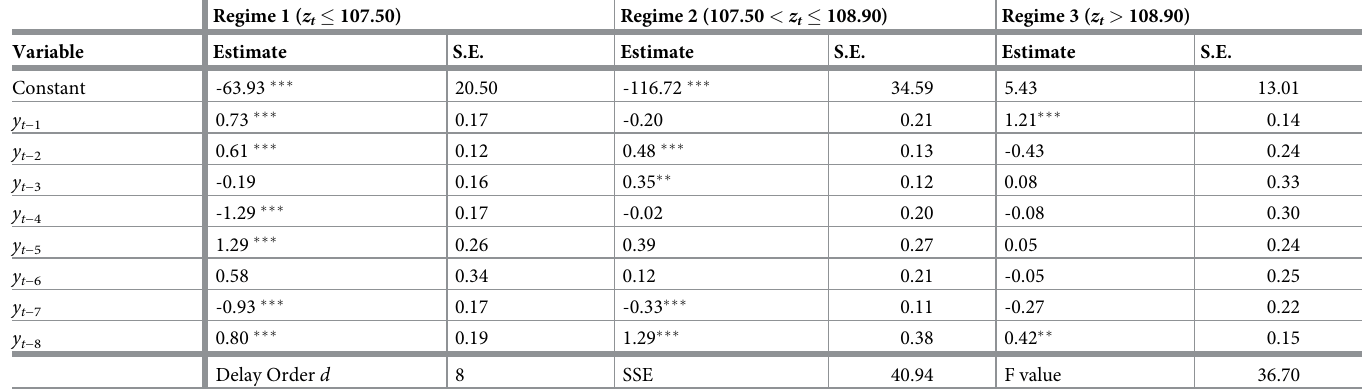
Table 6. The results of the threshold auto-regression model of the GDP growth rate. Regime 1 ( z t � 107.50)